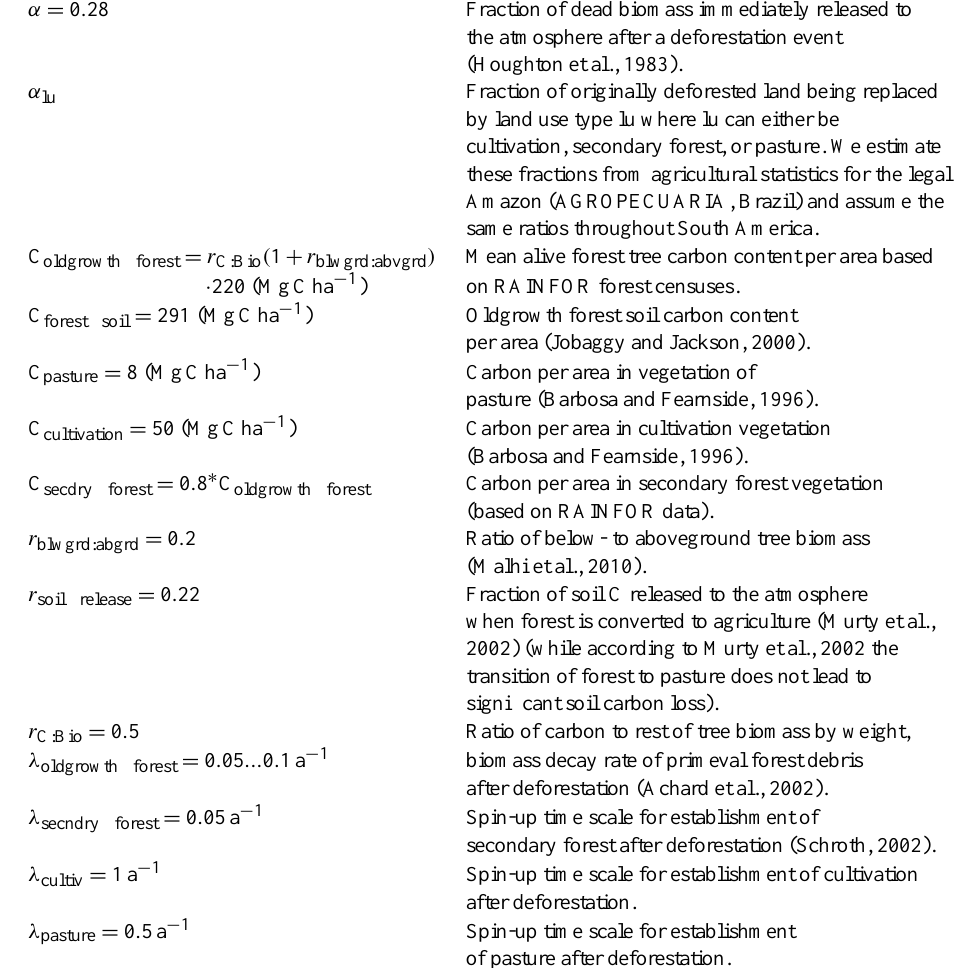
Table 6. Parameters of book-keeping model to estimate deforestation carbon fluxes. α = 0 . 28 Fraction of dead biomass immediately released to the atmosphere after a deforestation event (Houghton et al., 1983). α lu Fraction of originally deforested land being replaced by land use type lu where lu can either be cultivation, secondary forest, or pasture. We estimate these fractions from agricultural statistics for the legal Amazon (AGROPECUARIA, Brazil) and assume the same ratios throughout South